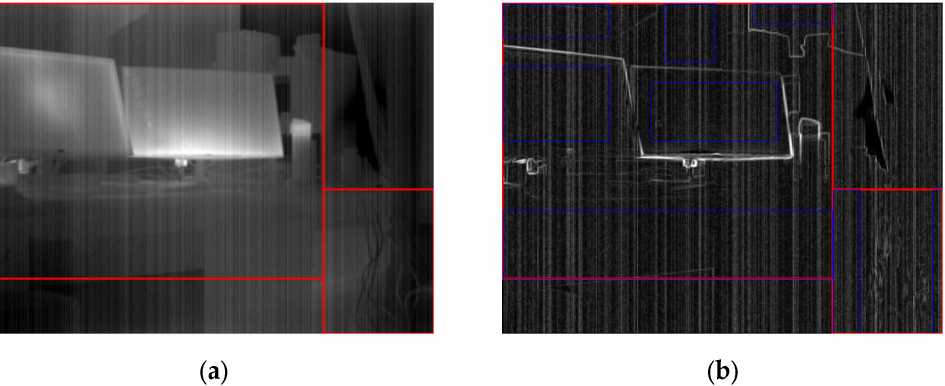
Figure 18. Real nonuniformity infrared image and its edge detection image: ( a ) real nonuniformity infrared image, upper left region as real data 1, bottom right region as real data 2; ( b ) the edge detection image.